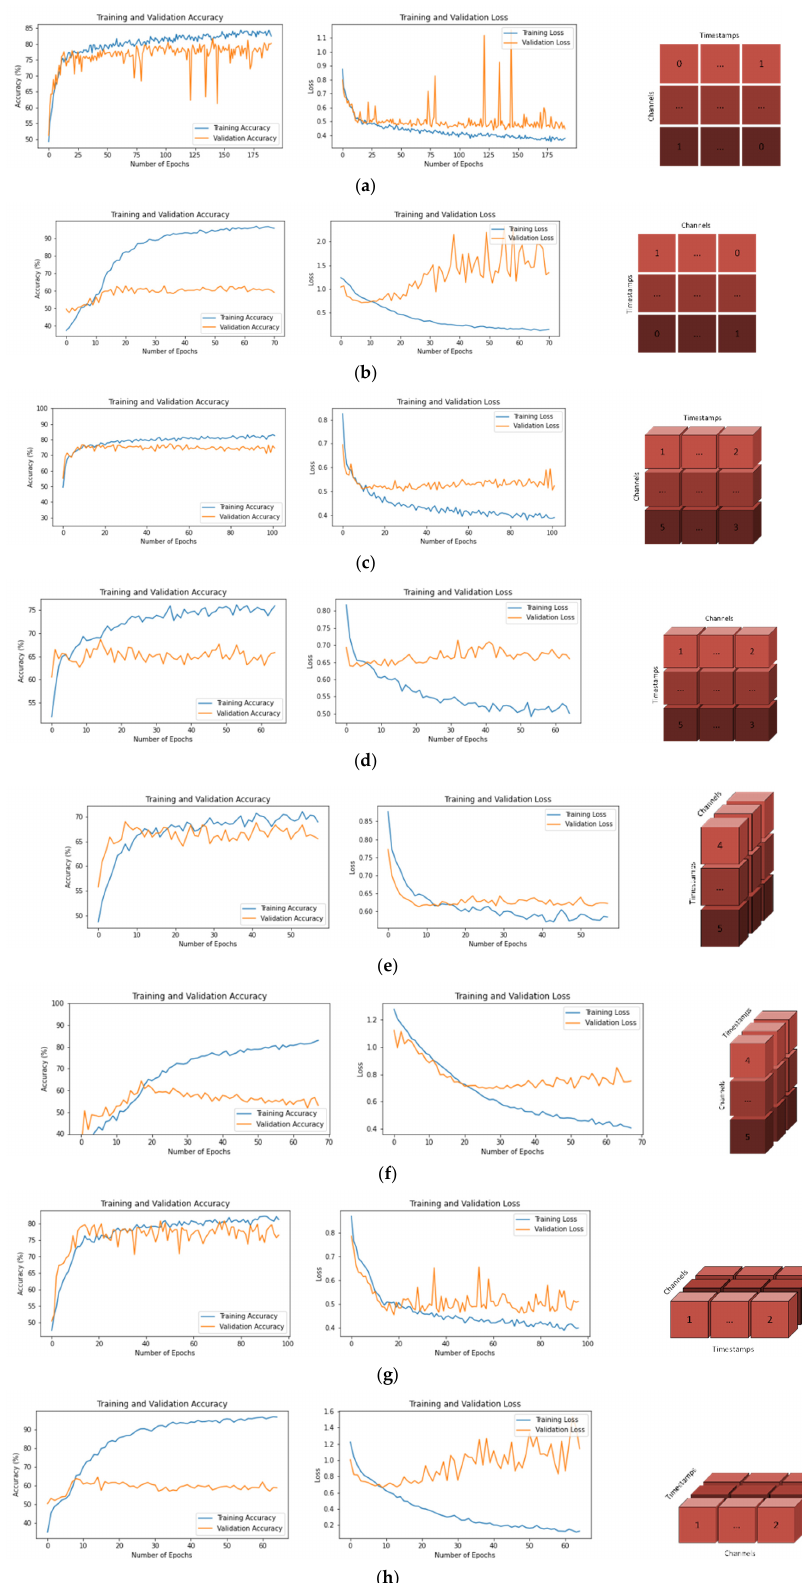
Figure 5. Training—Validation Accuracies and Losses for BCI-IV-2B Dataset and Input Shapes. ( a ) T × C, ( b ) C × T, ( c ) T × C × 1, ( d ) C × T × 1, ( e ) 1 × T × C, ( f ) 1 × C × T, ( g ) T × 1 × C, ( h ) C × 1 × T.